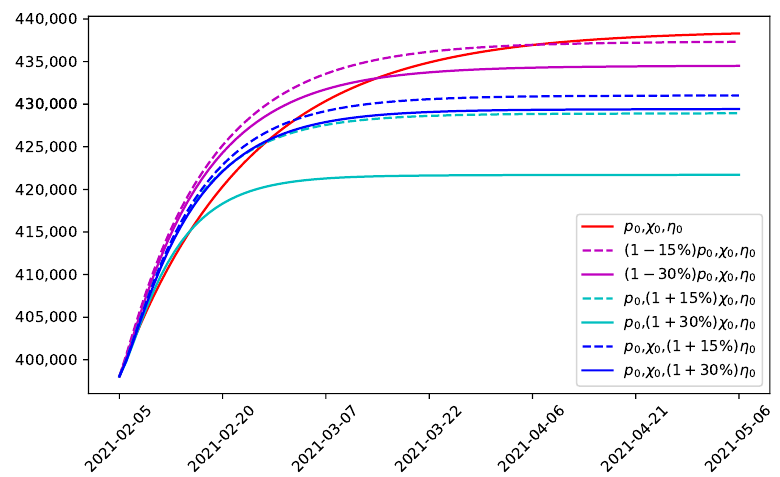
Figure 6. The prediction of the development of cumulative confirmed cases when changing the intensity of the strategies. Red line represents using the current strategy in the state of emergency; Pink lines represent using the modified strategies and lowering the ratio of untracked cases; cyan lines represent using the modified strategies with strengthened PCR tests; blue lines represent using the modified strategies alongside promoting the COCOA application.